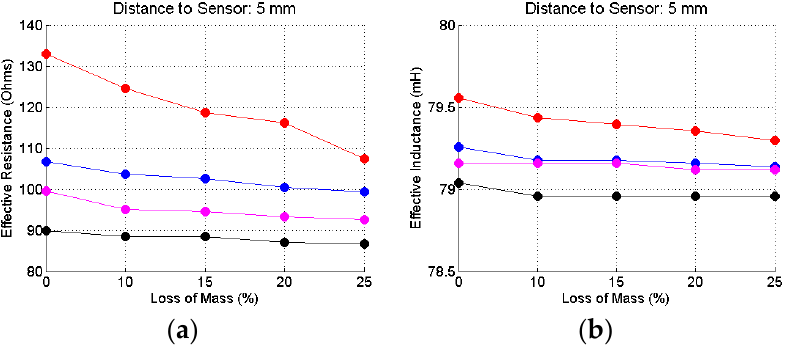
Figure 15. Resistance ( a ) and inductance ( b ) for the steel bars at the reference distance of 5 mm.